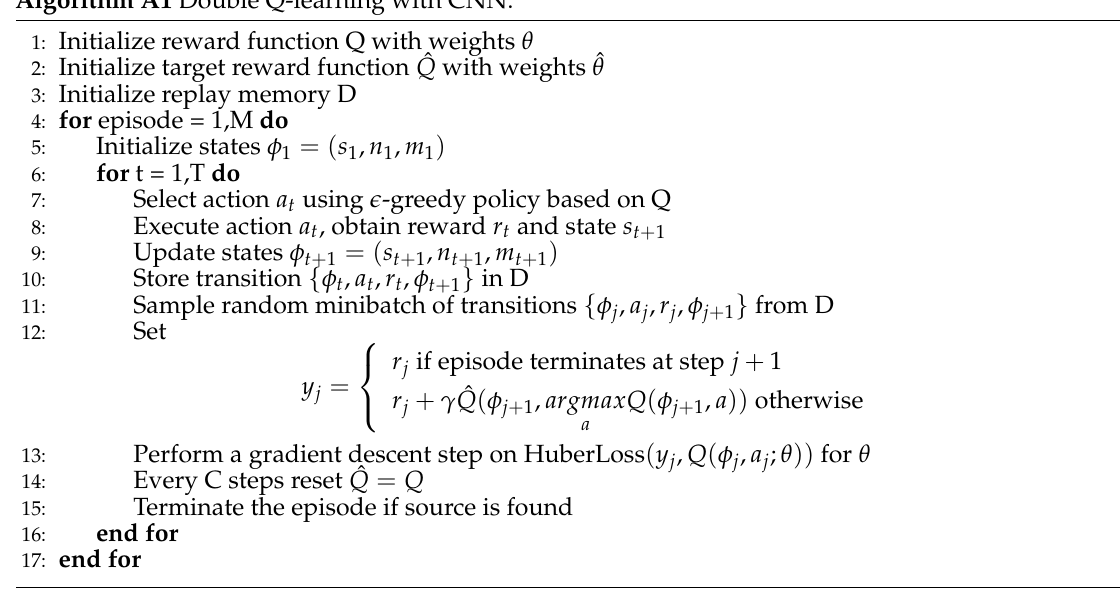
Algorithm A1 Double Q-learning with